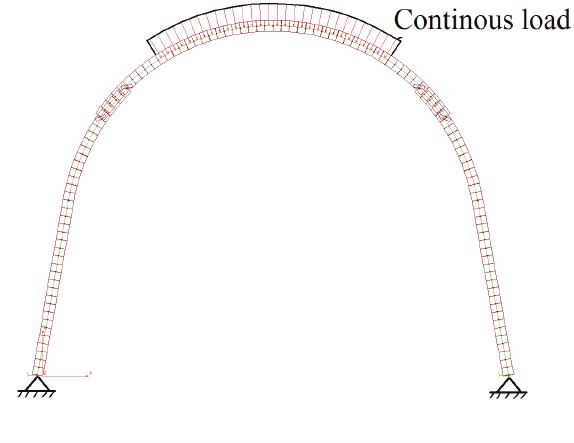
Figure 6: Variant II of the load on the frame.